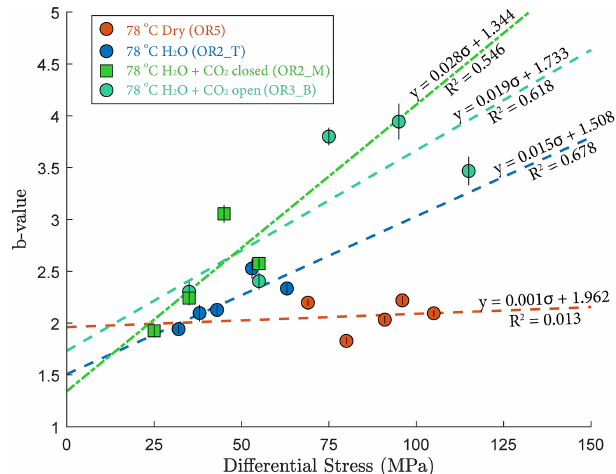
Figure 9. Differential stress dependence of Gutenberg–Richter b values. See detailed b -value fitting in Fig. A7. The error bar marks the 95% confidence interval of the calculated b